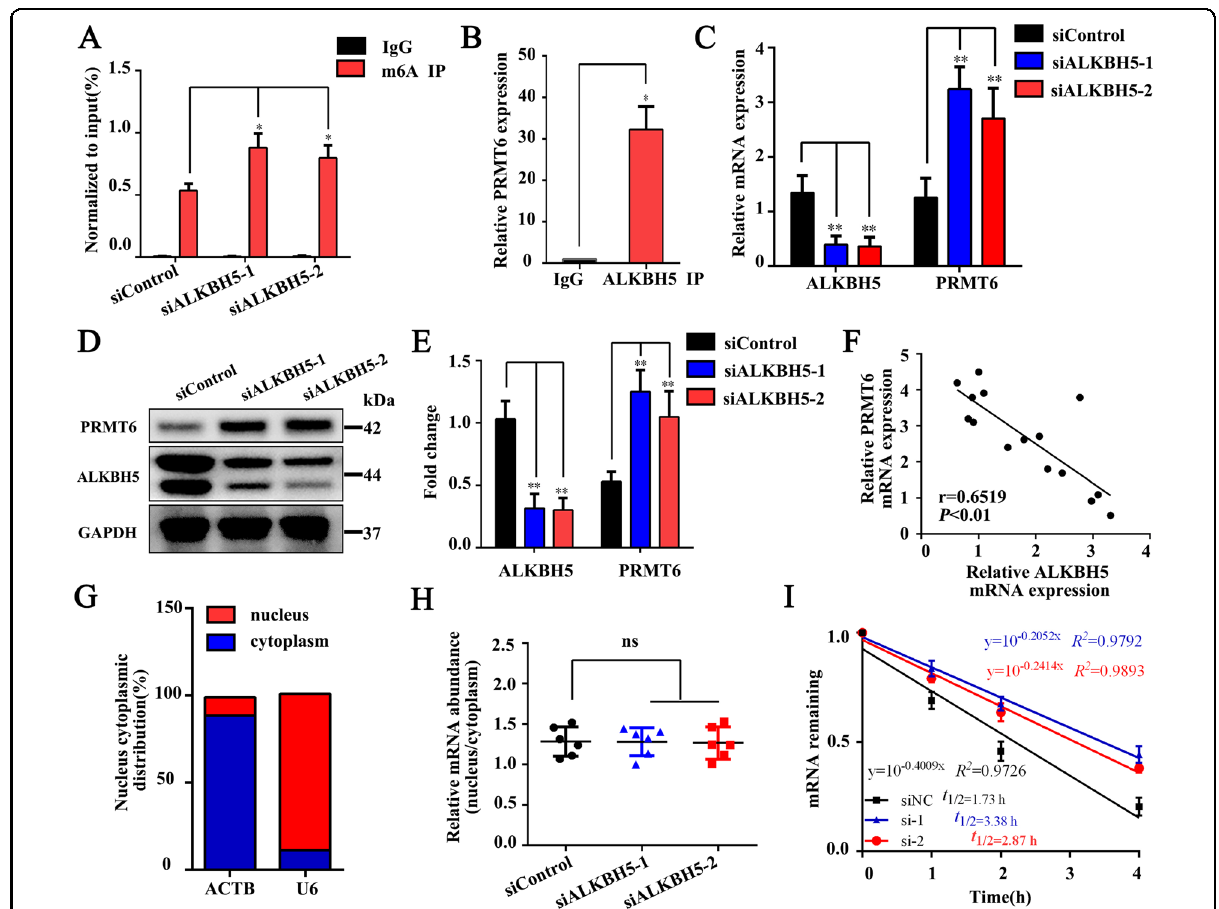
Fig. 5 ALKBH5 downregulates the expression of PRMT6 through m 6 A modi fi cation. A meRIP-qPCR analysis of PRMT6 mRNA in the siControl and siALKBH5 groups ( n = 6). B RIP-qPCR detected whether ALKBH5 and PRMT6 were directly bound ( n = 6). C qPCR results of PRMT6 after interfering with ALKBH5 expression ( n = 9). D , E After interfering with ALKBH5 expression, western blotting was used to detect and quantify PRMT6 ( n = 9). F Correlation analysis of PRMT6 and ALKBH5 during osteogenic differentiation of MSCs ( n = 15). G Nuclear and cytoplasmic fractionation assays following qPCR in the siControl and siALKBH5 groups ( n = 6). actin β ( ACTB ) and U6 small nuclear 1 ( U6) were used as the positive controls. H